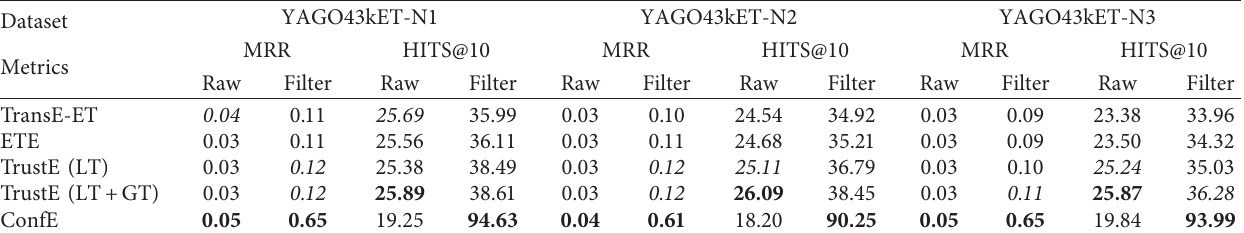
Table 4: Entity type prediction results. Evaluation of different models on YAGO43kET-N1, YAGO43kET-N2, and YAGO43kET-N3.